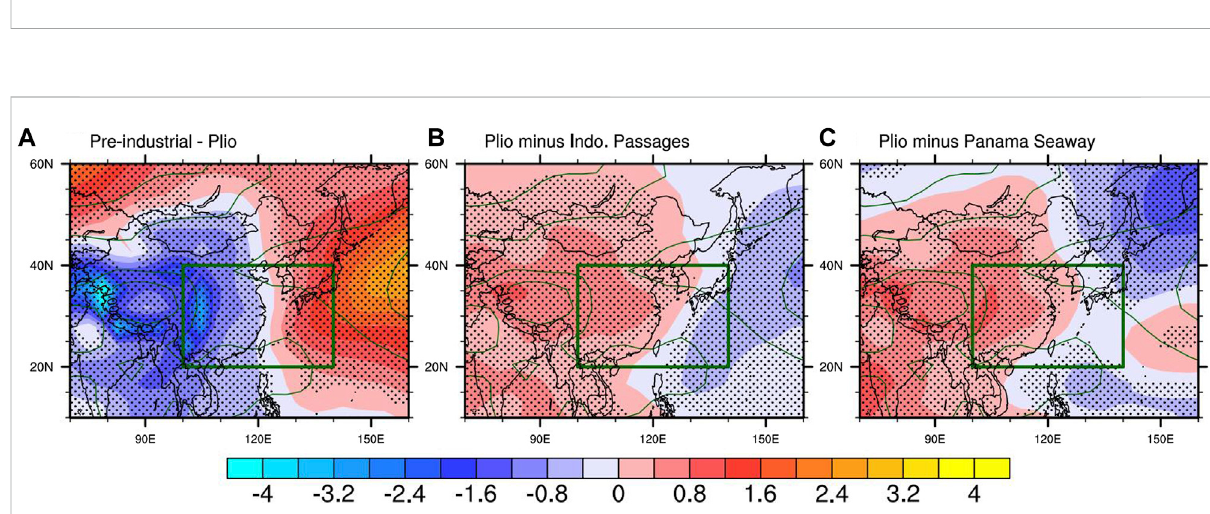
FIGURE 4 (A) Observed difference between PRISM SST dataset and HadISST dataset (averaged between 1870 and 1900) showing the observed SST change between the mid-Pliocene and the pre-industrial. (B) Scatter plot showing the simulated SST difference betweenPlio and Pre-industrial and the observed SST difference.